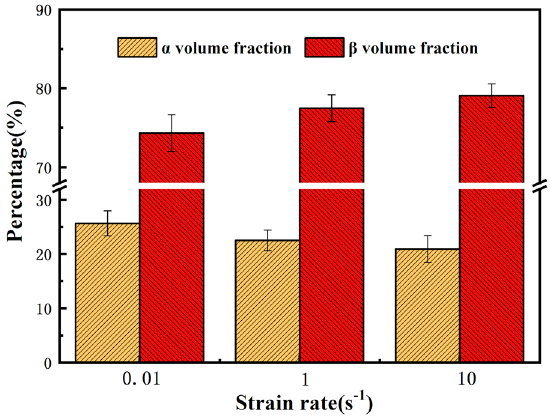
Figure 10. The variation of phase content with strain rate at constant temperature (750 °C).